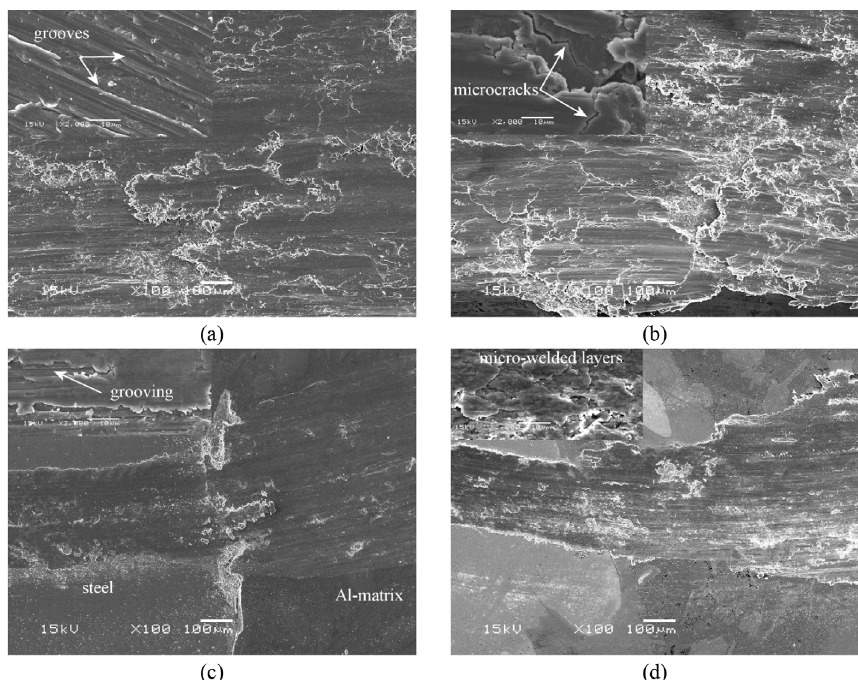
Figure 6: SEM micrographs showing the worn surfaces of cast A7075 (a and b) and A7075/SAF 2025 composite (c and d) materials contacted with 100Cr6 (a and c), ZrO 2 counterpart (b and